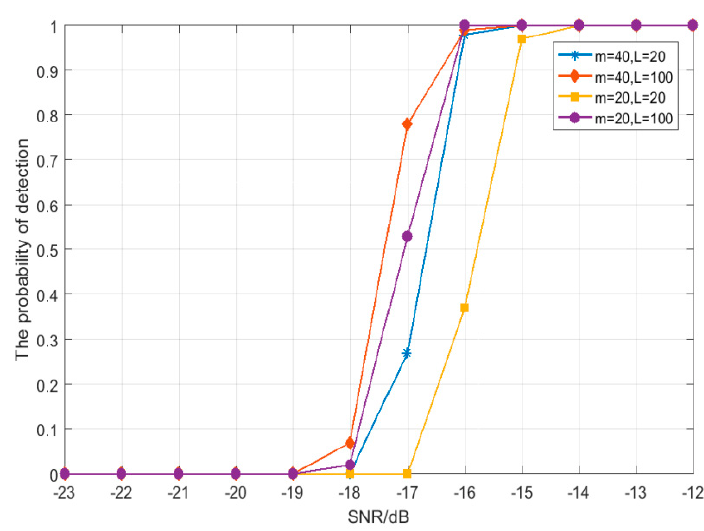
Figure 10. The relation between detection probability and SNR with different m and L combinations and a fixed J ( J = 4).